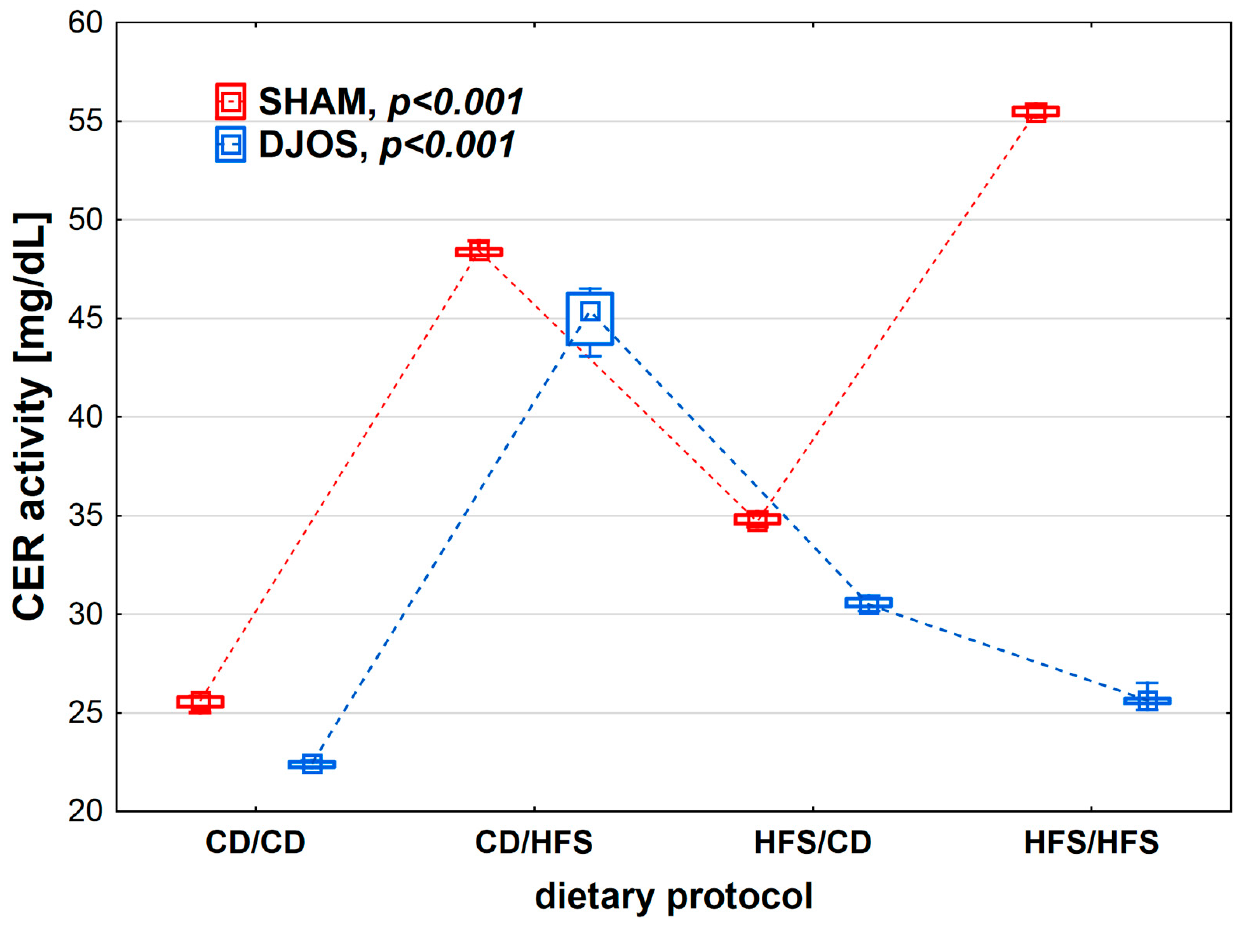
Figure 3. Ceruloplasmin (CER) activity (mg/mL) in the plasma of Sprague-Dawley rats subjected to duodenojejunal omega switch (DJOS) and control (SHAM) surgery and different dietary protocols at 8 weeks after the surgery. Legend: CD—control diet, HFS—high-fat/high-sugar diet. The inner boxes represent the medians, the outer boxes represent interquartile ranges, and whiskers represent min–max range. For the reader’s convenience, the medians are connected with dashed lines. We found statistically significant differences in TAC levels depending on the dietary protocol, after both SHAM ( p < 0.001) and DJOS surgery ( p < 0.001). We noted the highest TAC levels in the CD/CD groups. Rats subjected to SHAM surgery presented lower TAC levels in all dietary groups compared to rats subjected to DJOS (Figure 4).